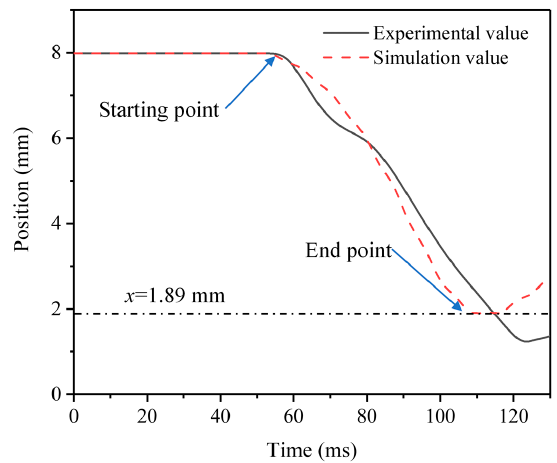
Figure 4. Measurement results of response time.